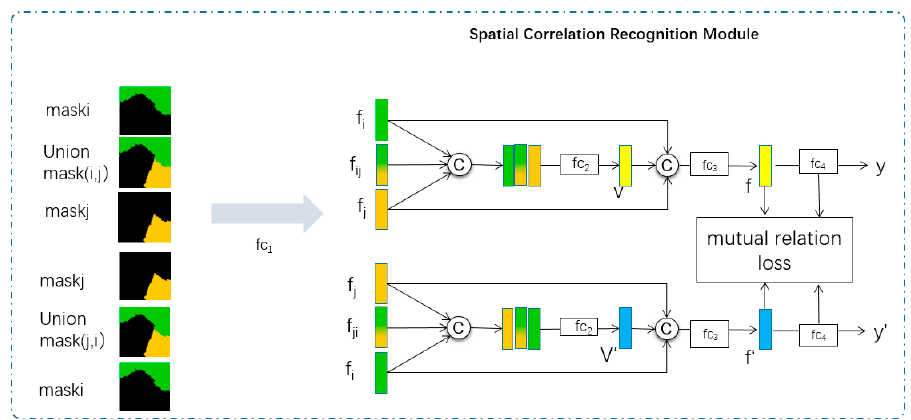
(k = 1, 2, 3, 4) (cid:2921)